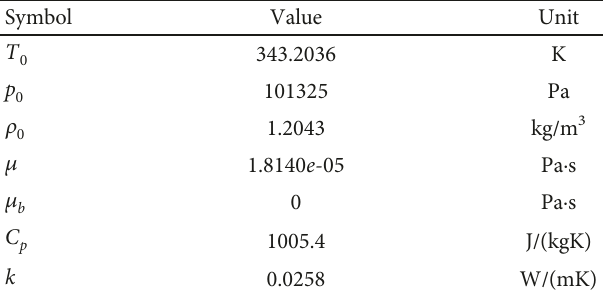
Table 1: Properties of air used in all models. Symbol Value